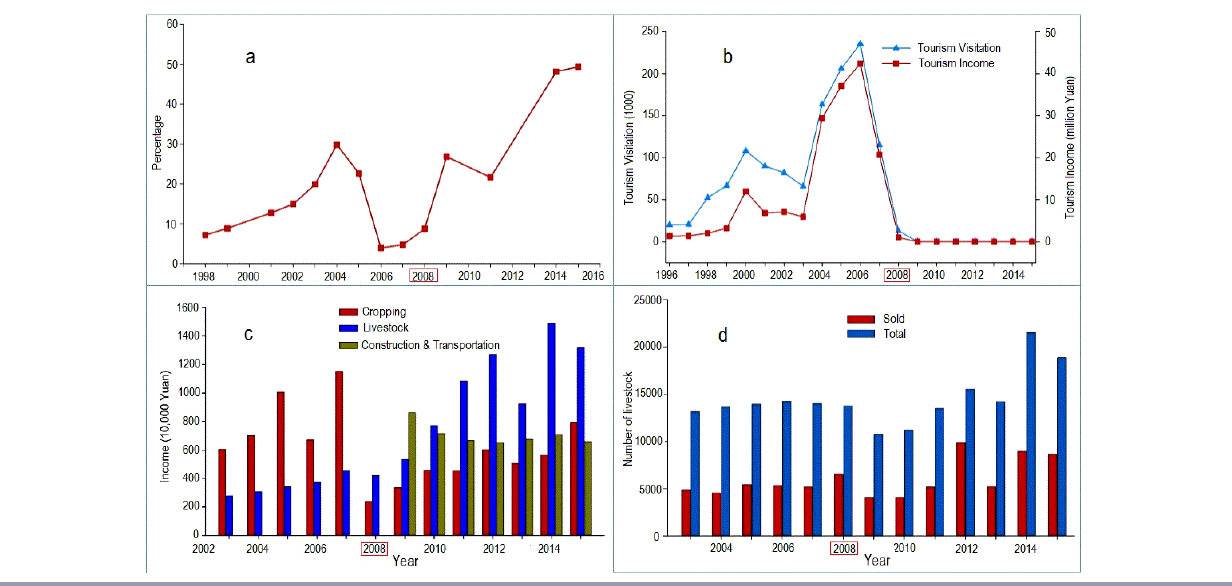
Fig. 3 . The dynamics of multiple flows between Wolong and the outside cities. (a) The annual percentage of households with labor migrants temporarily working in cities (based on household interview data by researchers in CSIS); (b) annual tourist visitation and income from tourism; (c) annual income from selling agricultural products, livestock trade, and transportation and construction; we conducted an inflation adjustment using 2008 as a baseline; and (d) annual livestock stock and sales in Wolong; we conducted an inflation adjustment using 2008 as a baseline (the data for b, c, and d were from the annual census of the Wolong Administration